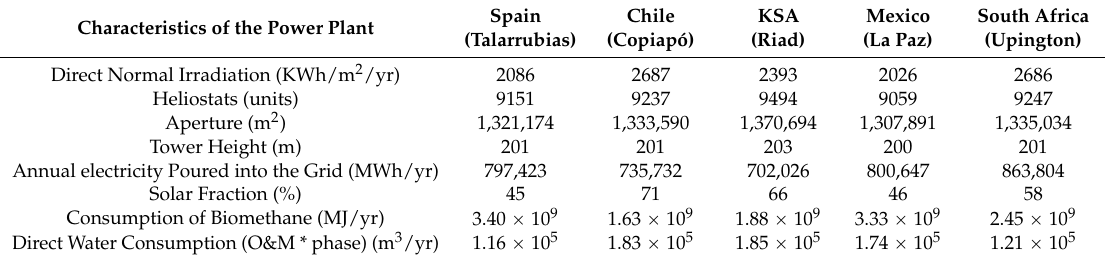
Direct Water Consumption (O&M * phase) (m 3